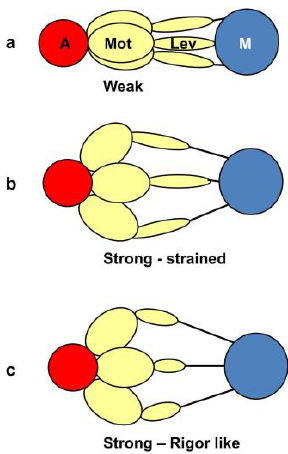
Figure 12. The equivalent schematic transitions to Figure 11, but this time as viewed down the fibre axis, i.e., as it would appear on the equator. The weak binding state AM.ADP.Pi would presumably have the motor domains in a loose (non-stereospecific) attachment to actin ( a ); so the heads would point back to their origins on myosin. The release of products would require the motor domains to become stereospecifically bound to actin, so they would follow the actin helix and become more spread azimuthally ( b ); The heads would still be axially strained as in Figure 11b. Relative filament sliding as in Figure 11c would relieve the strain by allowing the lever arms to tilt ( c ) and the strain would gradually reduce to zero. On the equator, configurations ( b , c ) would probably appear rather similar because of the relatively low mass of the lever arm. In other words, the modelled rigor-like state would include both ( b , c ).